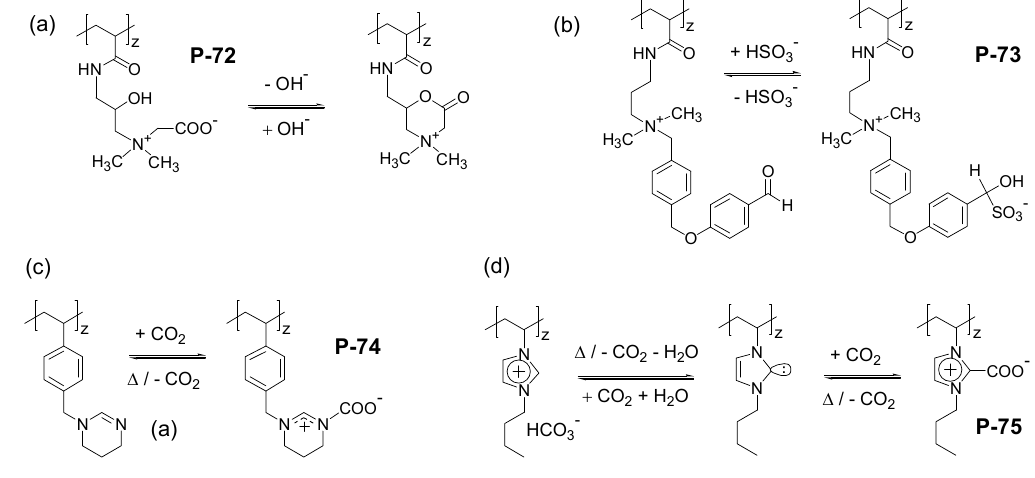
Figure 17. Chemically switchable polyzwitterions: ( a ) by pH-induced lactonization [128,445]; ( b ) via bisulfite-aldehyde addition [425,446]; ( c ) and ( d ) via addition of CO or carbenes [442,443],